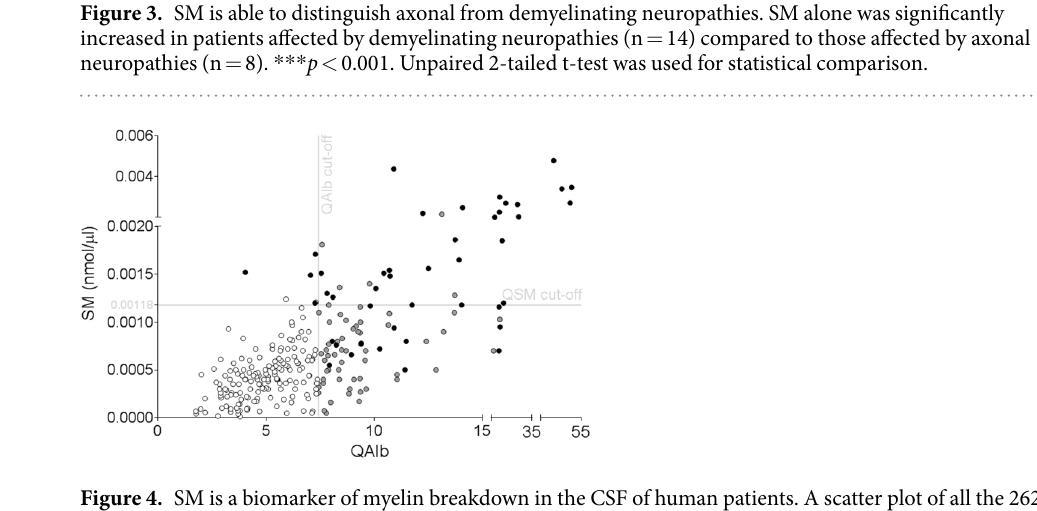
Figure 4. SM is a biomarker of myelin breakdown in the CSF of human patients. A scatter plot of all the 262 analysed patients based on QAlb and SM cut-off (X and Y axis, respectively) is shown. Notably, most of the patients with peripheral demyelination (Black circles) were over the SM threshold. Control subjects, either with or without BBB dysfunction (Grey and white circles, respectively) were also reported in the graph. Grey lines represent SM (Y axis) and QAlb (X axis) cut-off.